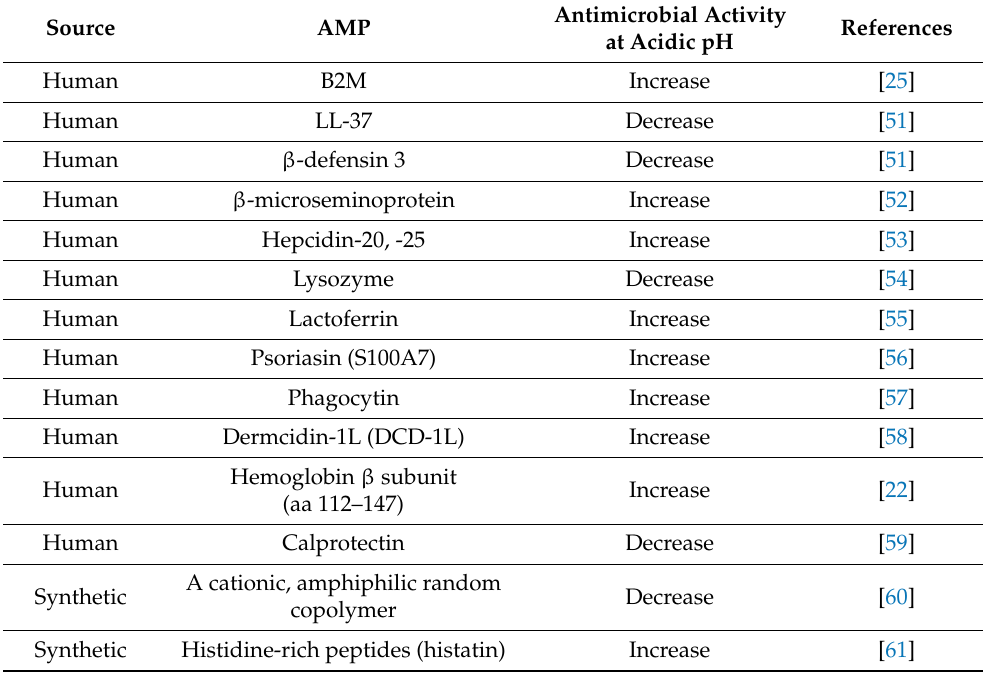
Table 2. Human and synthetic AMPs exhibiting pH-dependent antimicrobial activity. Source AMP